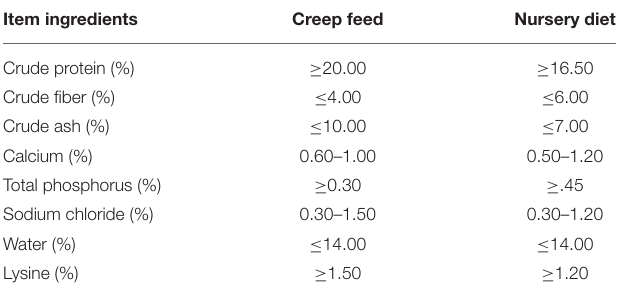
TABLE 1 | Diet formula of lactating-growing